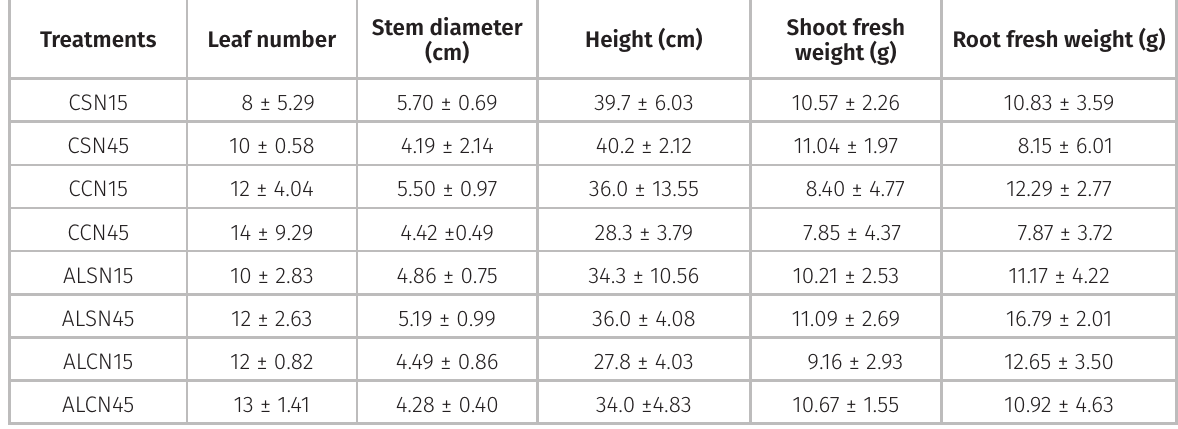
Table I. Growth parameters of guava seedlings inoculated (AL) or not (C) with A. longula and infected (CN) or not (SN) with M. enterolobii , at 15 or 45 days after inoculation with M. enterolobii , maintained on an experimental screen. Averages are not statistically significant (Duncan’s post-hoc test, alpha of 0.05, test was performed between all